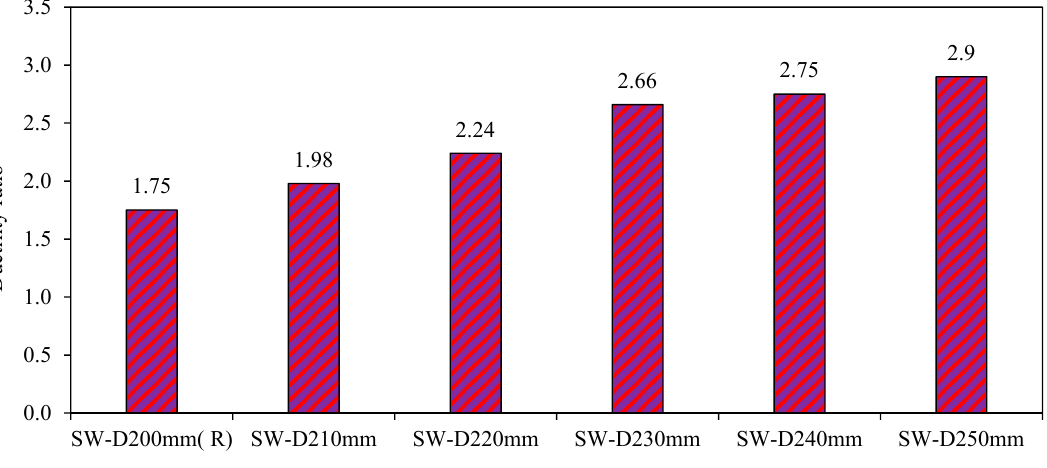
Figure 27. Ductility ratio of group 4.